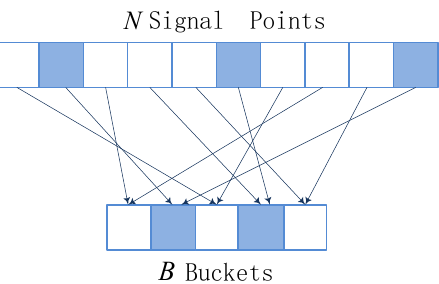
Figure 3. Schematic diagram of the bucketization process.